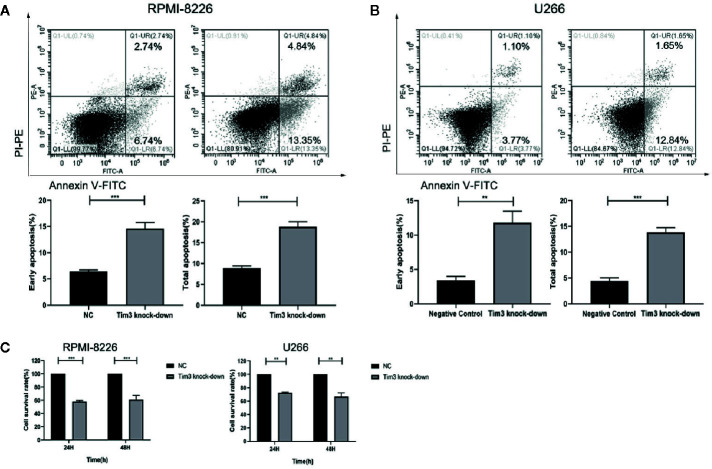
The effect of knocking down Tim3 on the apoptosis and proliferation of MM cell lines. (A) The effect of knocking down Tim3 on the apoptosis of RPMI-8226. (B) The effect of knocking down Tim3 on the apoptosis of U266. (C) The effect of knocking down Tim3 on the proliferation of RPMI-8226 and U266. Shown are average values with standard deviations. Data are performed from 3 independent experiments. ** indicated p<0.01, *** indicated p<0.001.